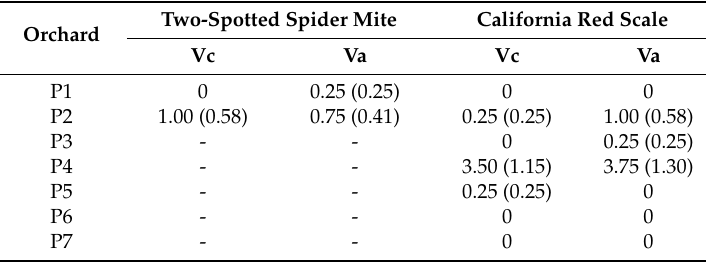
Table 7. Percentage of cull fruit (%) (mean (standard error)) at harvest in each orchard due to each pest with each treatment. Two-Spotted Spider Mite California Red Scale Orchard